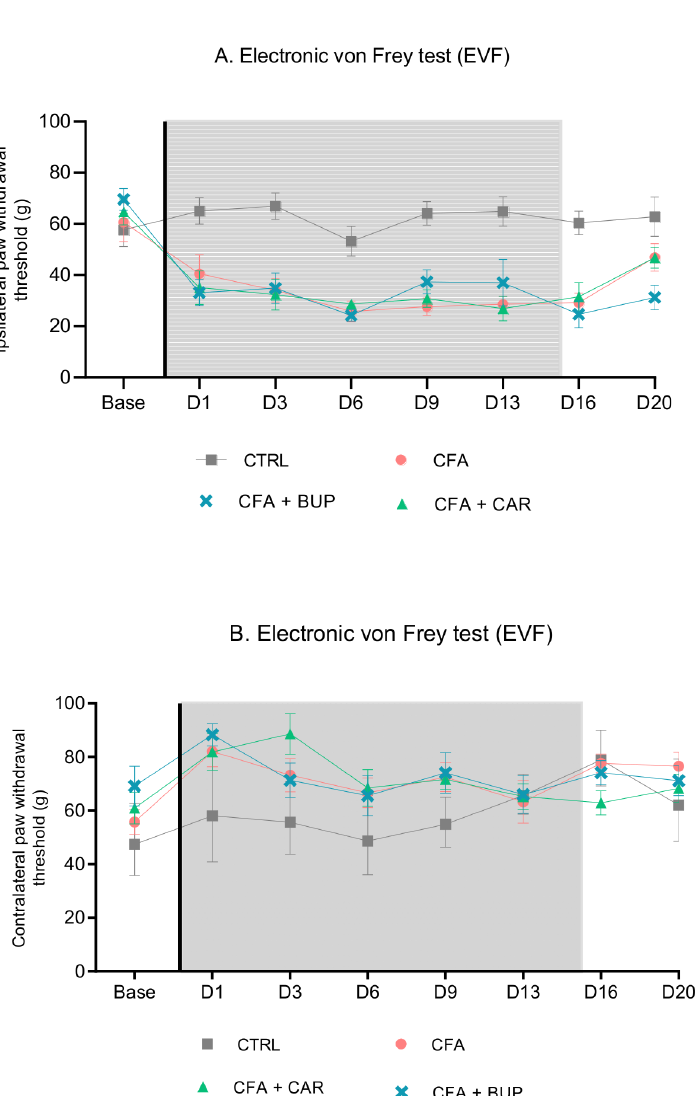
Fig 5. Assessment of mechanical threshold. Effects of buprenorphine and carprofen on paw withdrawal thresholds (g) as an expression of mechanical hyperalgesia. (A) Ipsilateral (left, CFA-injected paw) paw withdrawal thresholds. (B) Contralateral (right, non-injected paw) paw withdrawal thresholds. Data are analysed by a two-way RM ANOVA followed by a Tukey’s multiple comparisons test D1, D3, D6, D9, D13, D20 and presented as mean ± SEM. For all graphs: base = baseline values, D = day, the line represents the day of analgesic treatment initiation (D0) and the grey area represents the treatment period (15 days). All groups: n = 8, male Sprague Dawley rats.